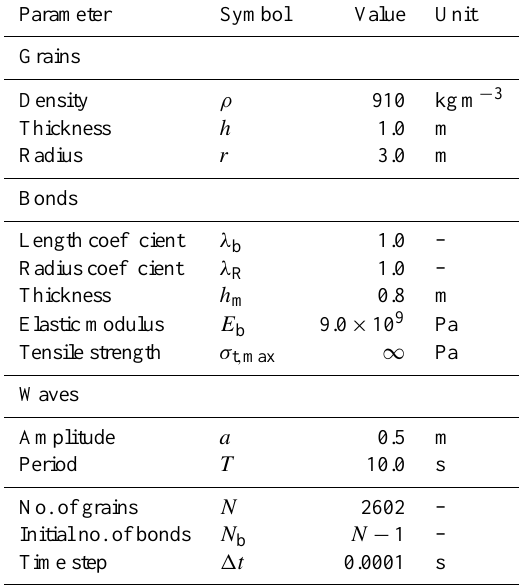
Table 2. Physical and numerical model parameters used in the ref- erence simulations in Sect. 8.2.1.